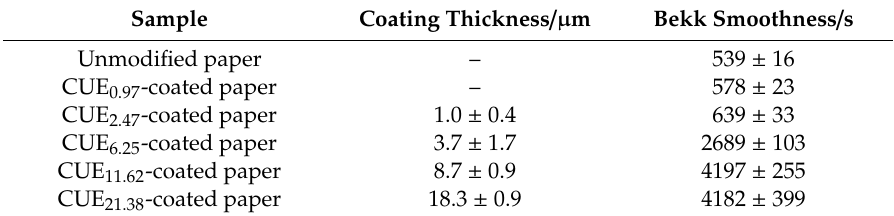
Table 1. Coating thickness and air penetration time of CUE 0.97 -coated paper, CUE 2.47 -coated paper, CUE 6.25 -coated paper, CUE 11.62 -coated paper and CUE 21.38 -coated paper.